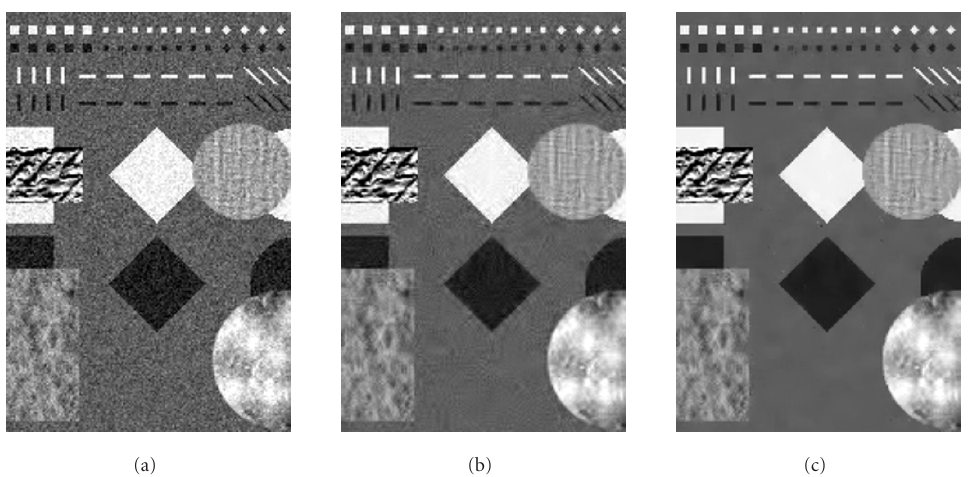
Figure 9: Visual results of processing the test image corrupted by Gaussian noise with σ 2 n = 200: (a) original noisy image, (b) the 8 × 8 DCT filter output, and (c) the result of image processing by the proposed three-component hard-switching LAF.